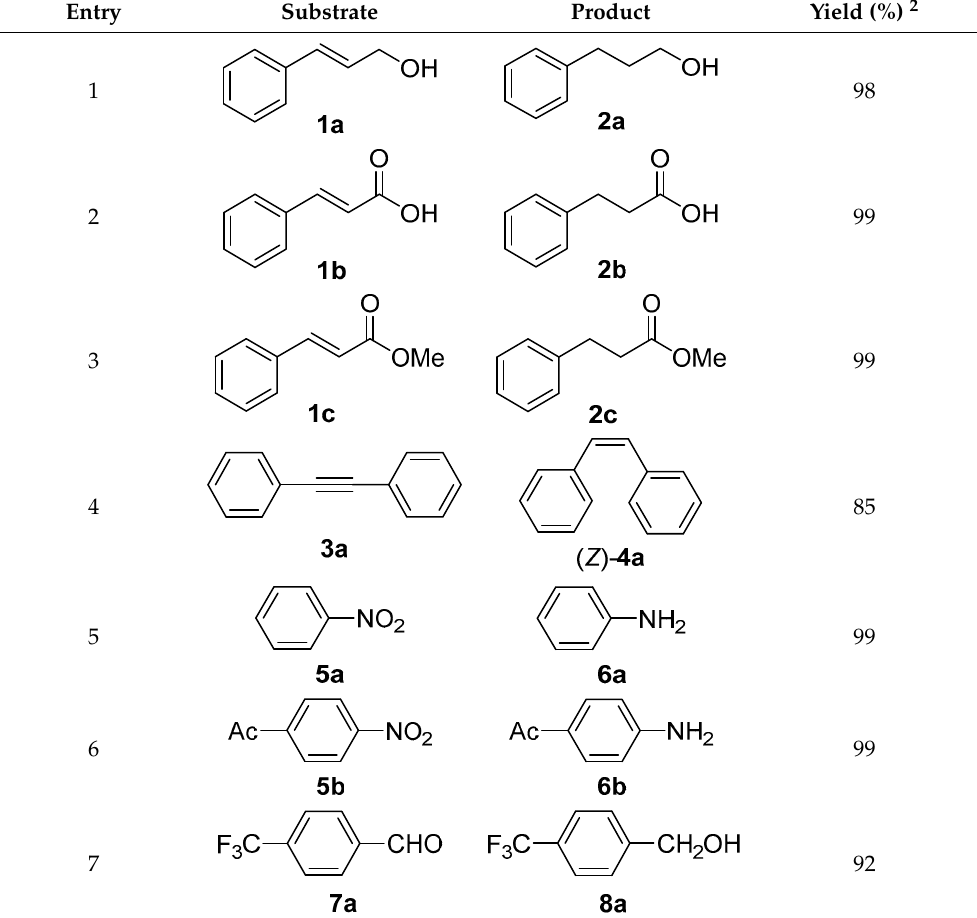
Table 2. Transfer hydrogenation catalyzed by bis -NHC–Ag/Pd(OAc) 2 catalytic system 1 . Entry Substrate Product